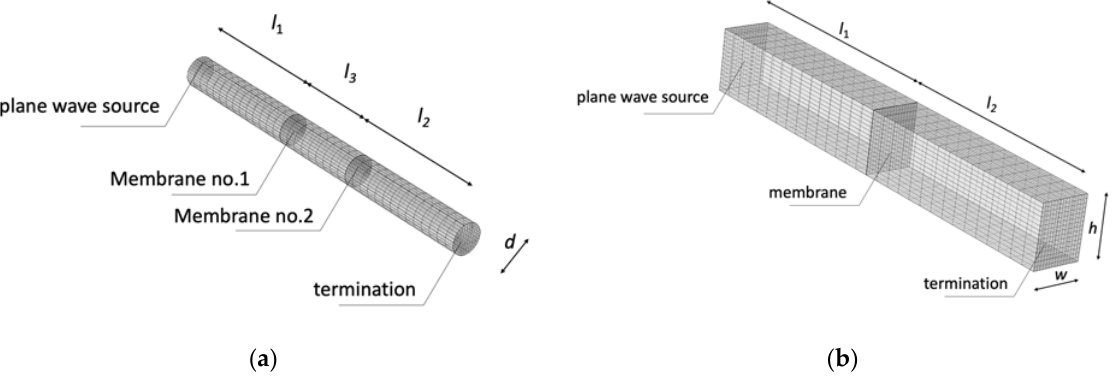
Figure 3. View of 3D FEM model meshing. ( a ) Single membrane; ( b ) rectangular shape membrane, where l 1 , l 2 , h , w , d are length of downstream and upstream part of impedance tube, height, width and diameter of the tube cross section, respec- tively.